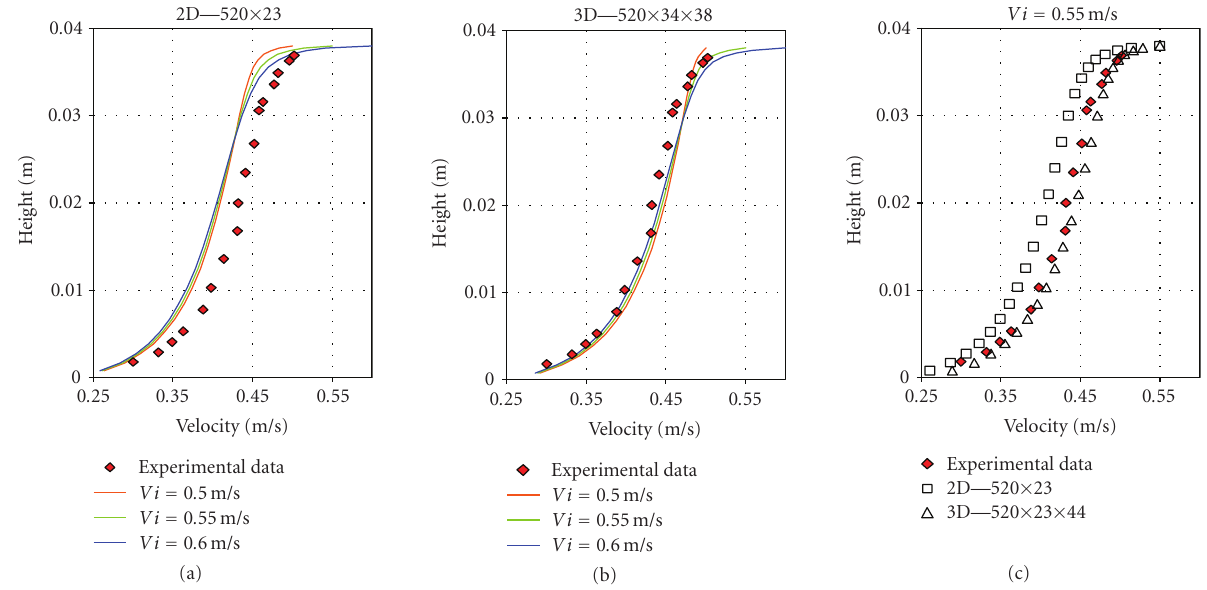
Figure 4: Water velocity: (a) 2D grid with di ff erent interface velocities; (b) 3D grid with di ff erent interface velocities; (c) 3D versus 2D grids.